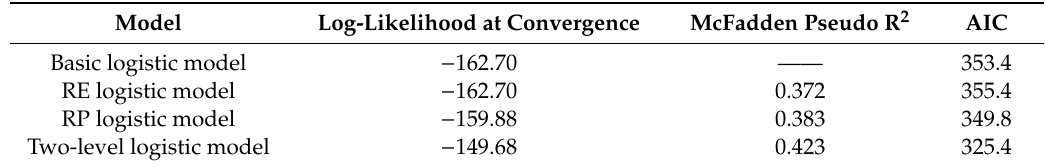
Table 2. The elasticity values for five main e ff ects were positive, namely speed limit, tra ffi c volume, rainy, cloudy and tunnel. Two other main e ff ects had a negative elasticity value: the number of lanes and the intercept. Table 3. Model comparison based on log-likelihood, McFadden Pseudo R 2 , and AIC.